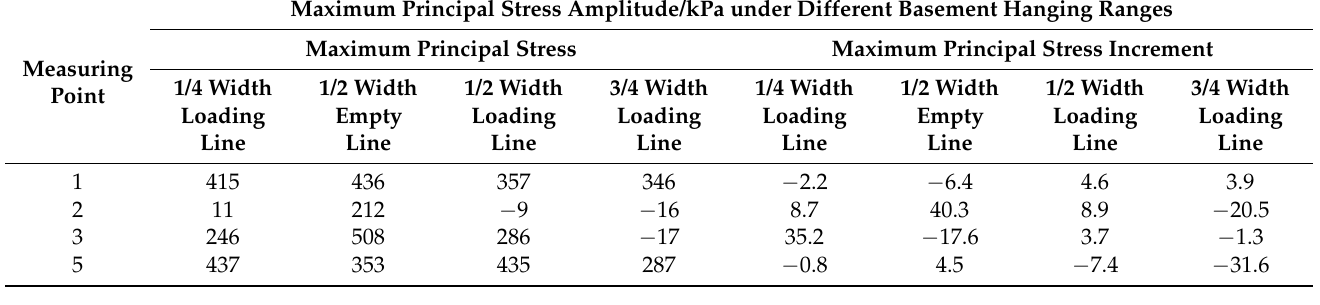
Table 15. Maximum principal stress amplitude of measuring points 1, 2, 3, and 5 under different basement hanging ranges.